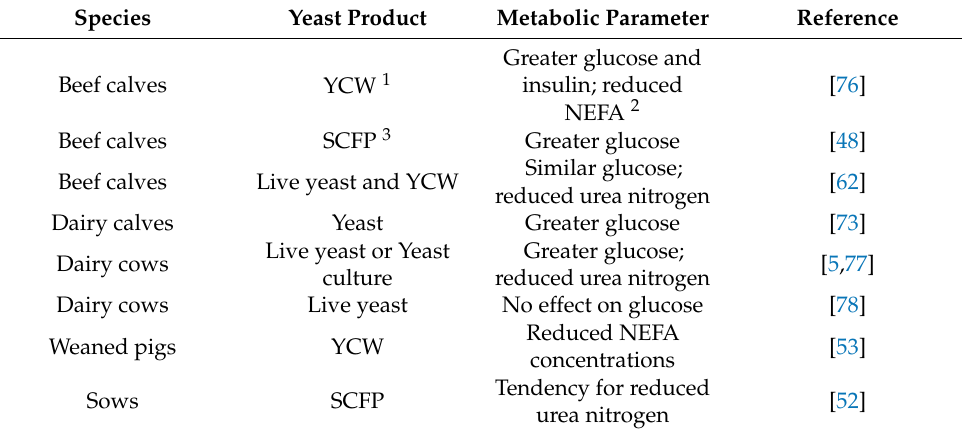
Table 2. Effects of yeast and yeast-based product supplementation on metabolic parameters in cattle and swine. Species Yeast Product Metabolic Parameter